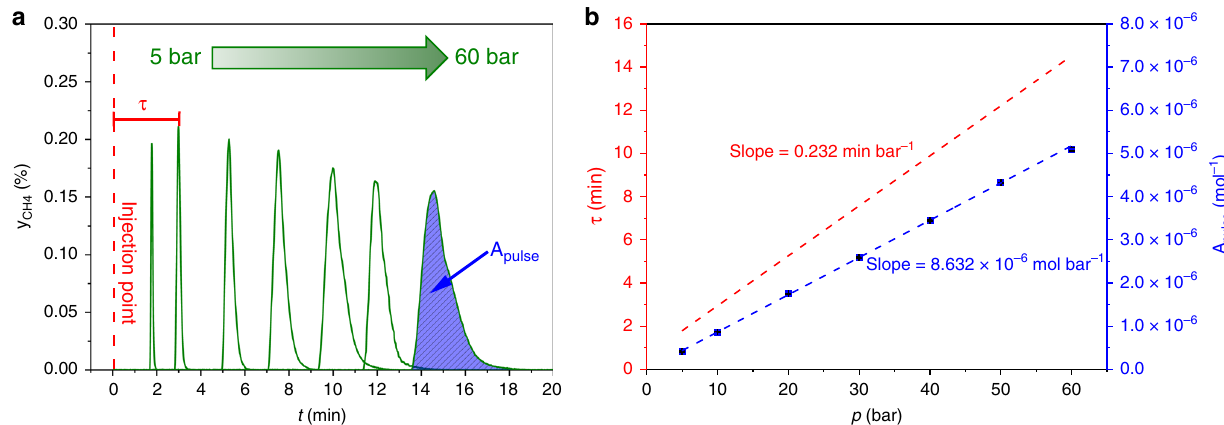
Fig. 6 Validation of the self-built high-pressure pulse unit with inert CH 4 pulses over α -Al 2 O 3 . a Recorded methane pulses (green curves) injected over α -Al τ is de fi ned as the retention time of the CH 2 O 3 as inert bed at different pressures from 5 to 60 bar. 4 pulses. b Correlation of the determined retention times τ (red points and line) and pulse areas A pulse (blue points and line) against the set pressure levels. The error bars were determined by measuring every point 5 times.